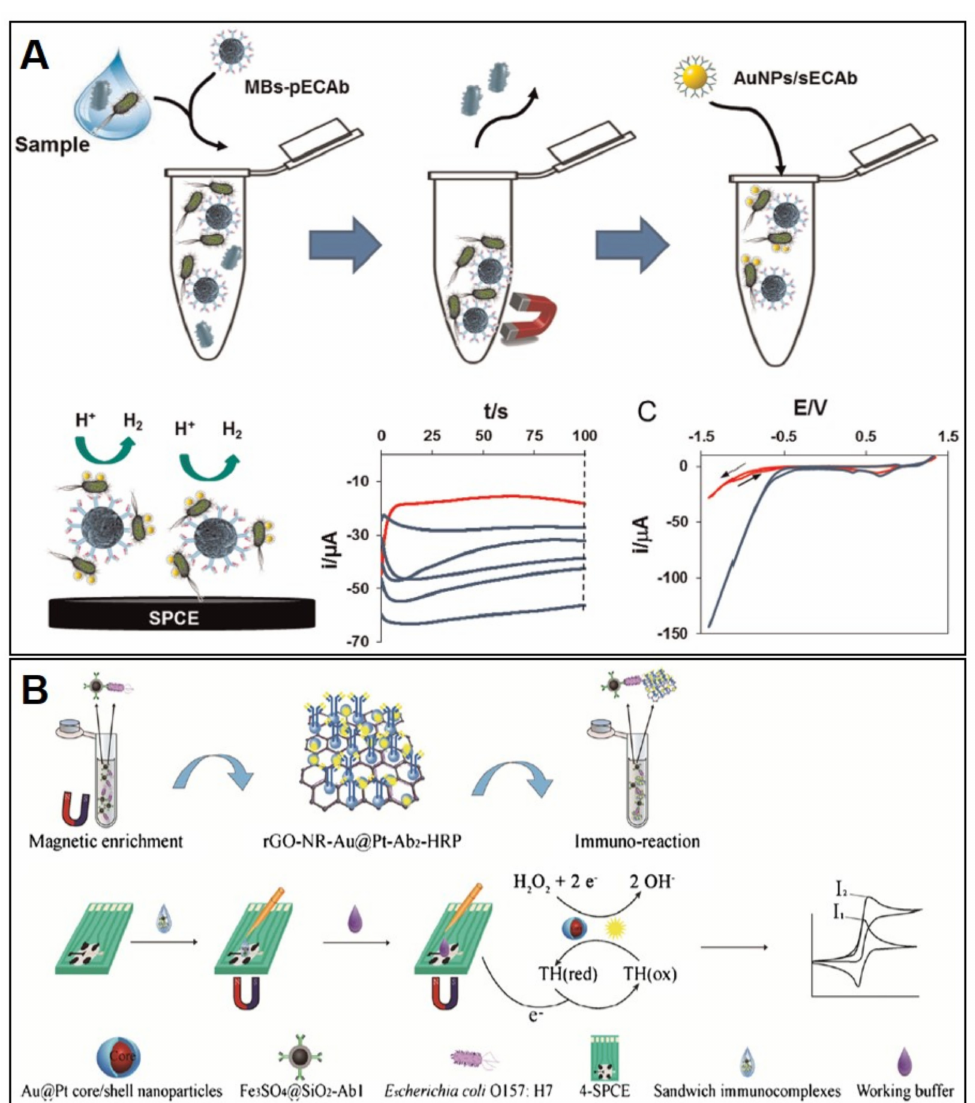
Figure 5. ( A ) Schematic representation of the magneto immunoassay developed by Hassan et al. for E.coli O157:H7 detection based on the Hydrogen Evolution Reaction electrocatalyzed by AuNP; chronoamperograms for di ff erent bacteria concentration; cyclic voltammograms in absence (red line) and presence of bacteria (blue line). Reproduced from [89] with permission from Elsevier. ( B ) Schematic representation of the magneto immunoassay, using rGO-NR-Au@Pt nanocomposite and HRP as label, developed by Wenchao Dou et al. E. coli O157:H7 detection. Reproduced from [92] with permission from Springer